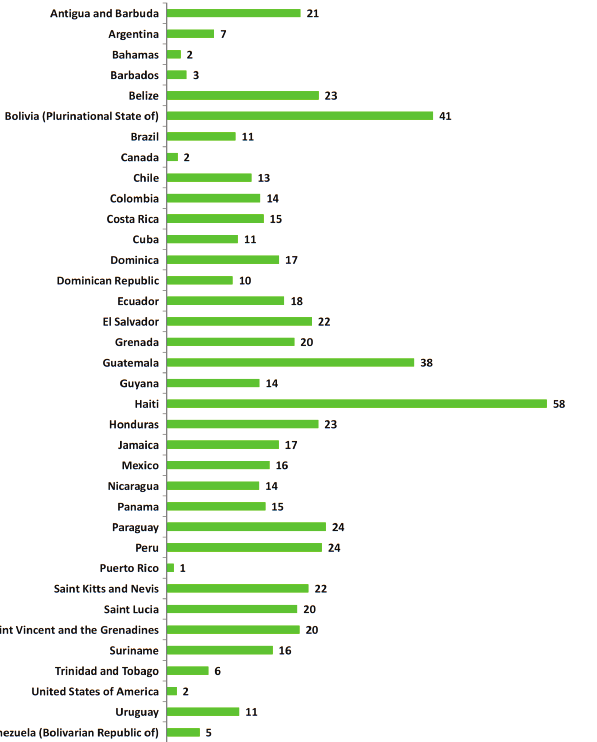
Figure 4: Human development index (HDI) in 2011, this index is not available for Puerto Rico